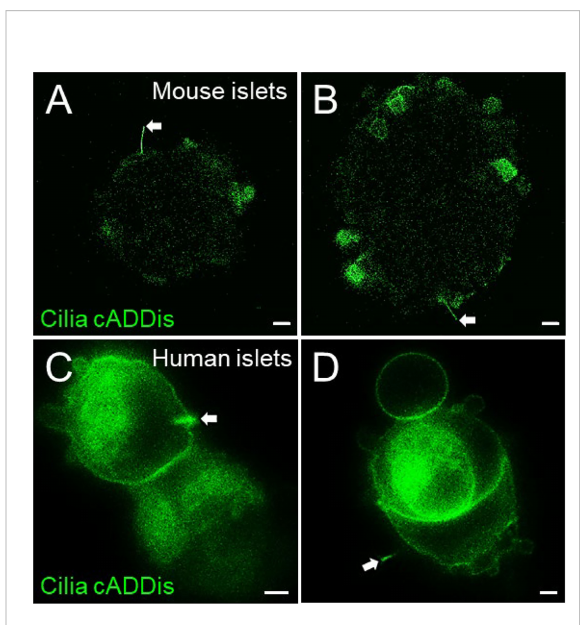
FIGURE 6 Green cADDis labeling of live islet cell cilia. Snapshot images from live-cell recordings of intact mouse islets (A, B) and partly dissociated human islets (C, D) 24 hours after transduction with baculovirus containing cilia-targeted green cADDis sensors. White arrows indicate primary cilia. Scale bars, 10 µm (A, B) , 2 µm (C, D) .